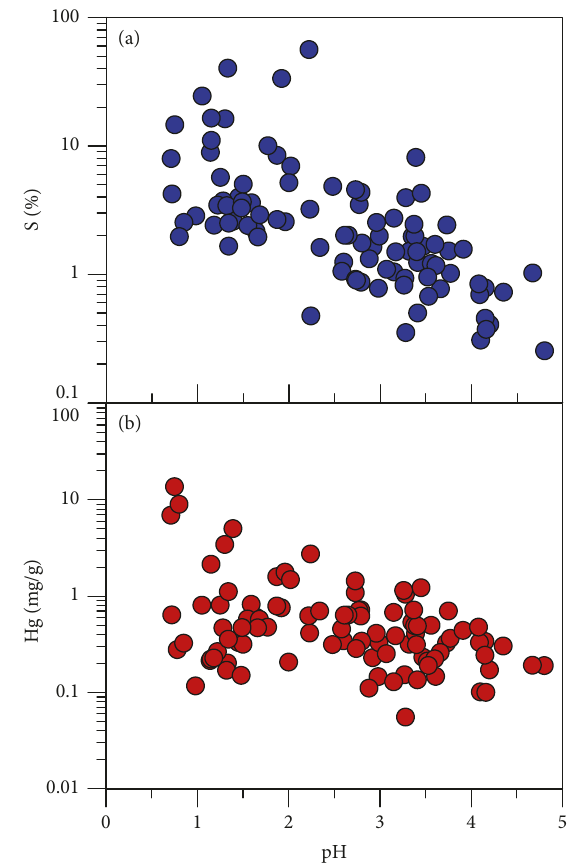
Figure 6: Soil total sulfur (a) and total Hg (b) concentrations vs. soil pH binary